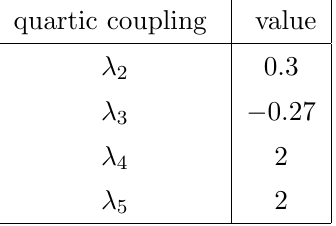
Table 2. Values of the scalar couplings motivated by a maximal reduction of the strength of y 2 ; 3 (cid:11) . Values are in accord with the limits coming from the requirement for the stability of the Higgs potential (see section 2.1), as well as